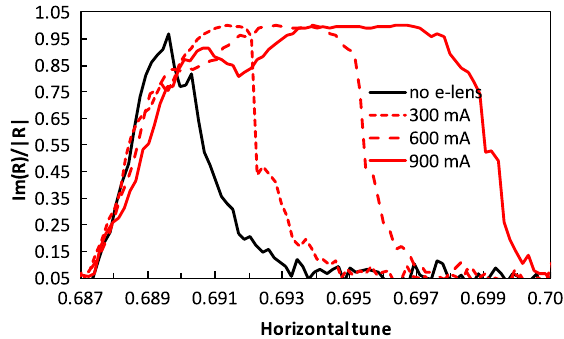
FIG. 14. Measured p beam tune distribution width as a function of the electron beam current without beam-beam collisions and ¼ 0 . 55 mm. The proton beam with an electron beam size of σ e ¼ 0 . 60 mm. The curves are aligned to the left with an size is σ p offset for better visibility of the effect [1].